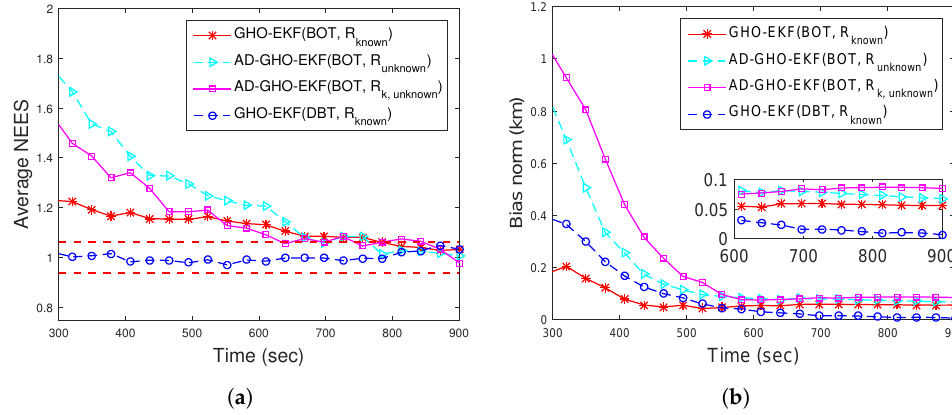
Figure 6. ( a ) ANEES and ( b ) position bias norm for BOT and DBT for Scenario I.